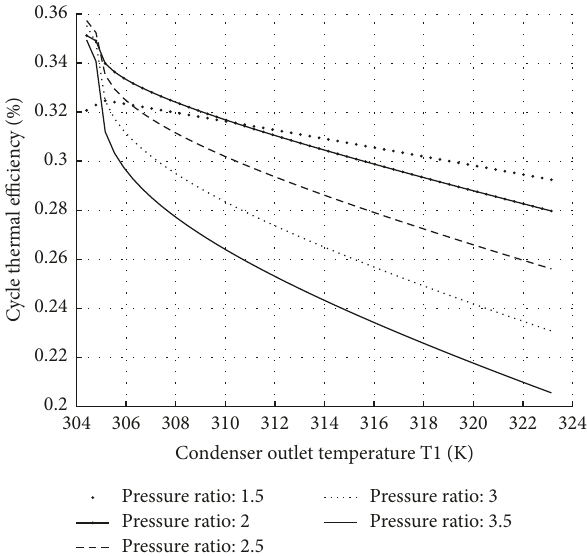
Figure 4: Effect of cycle pressure ratio on the thermal efficiency for different turbine inlet temperatures.